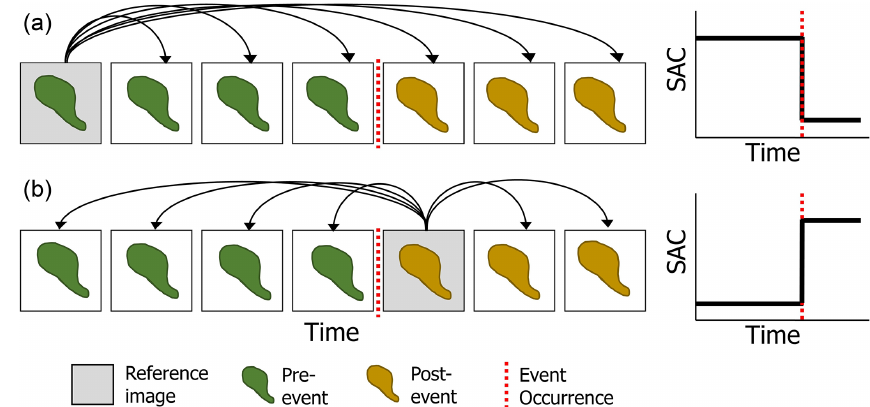
Figure 4. Idealised schematic of the SAC method using two different reference images: one before and one after the occurrence of the GH event (a, b) . Squares represent images; the red dotted line indicates the occurrence of a GH event. Inside the images are the conditions of the impacted area (represented here as single GH feature but similar for complete GH event). Pre-event conditions are displayed in green. Post-event conditions are displayed in brown. The black curved lines represent the combination of images on which Eq. (1) is applied to achieve the resulting SAC time series. The schematic SAC graphs (right) depict the expected results using a reference image before the event (a) with high correlation before and low correlation after the event and using a reference image after the event (b) with low correlation before and high correlation after the